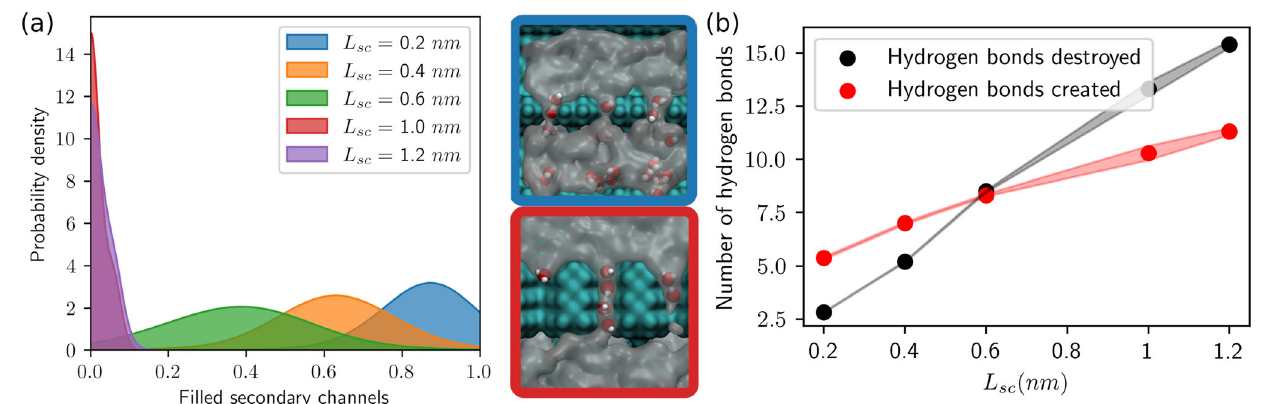
Fig. 4 Hydrogen bonds explain the fi lling of secondary channels. a Histogram of the fi lled secondary channels during molecular dynamics runs, for different secondary channel lengths, L sc . A single fi le of water molecules occupies secondary channels, as shown by molecular dynamics snapshots in the inset (blue for the secondary channels with L sc = 0.2 nm and in red for L sc = 1 nm). b Number of hydrogen bonds created by the water molecules in the secondary channels (red) and the ones destroyed (black) in order to move the molecules there, for different L sc in the fi lled state, using the empty state as